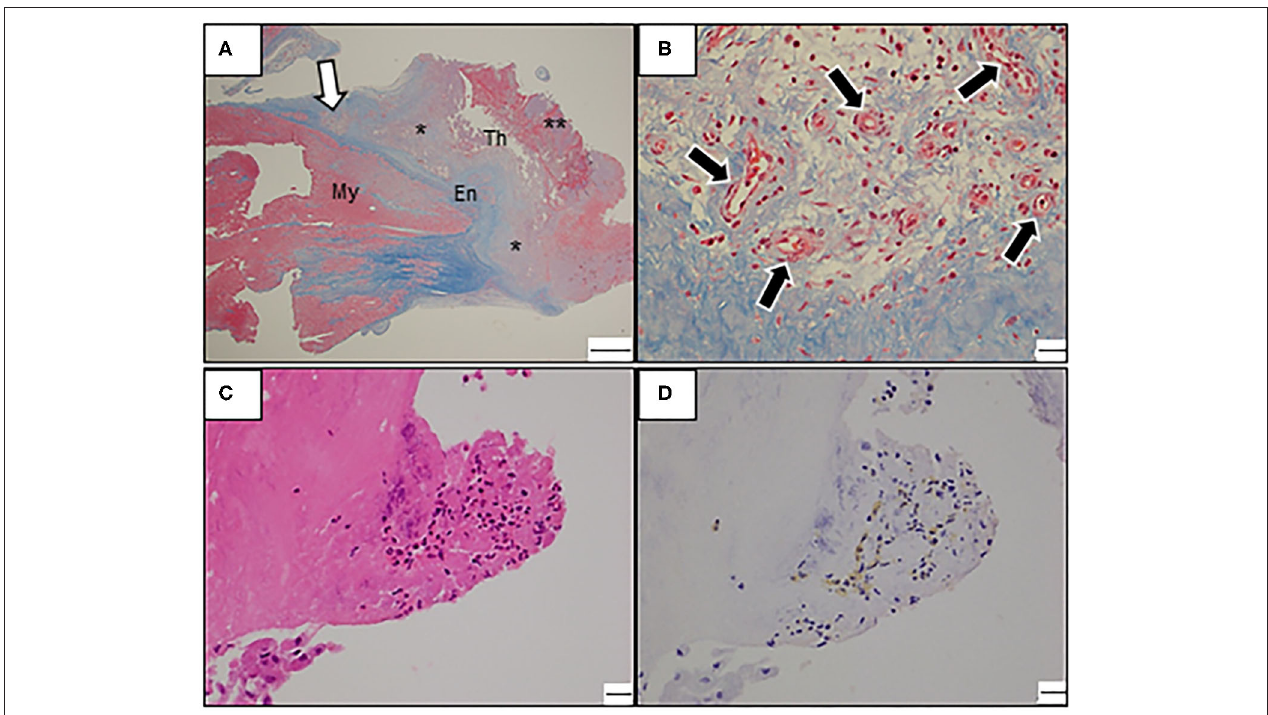
FIGURE 4 | (A–D) Photomicrograph of the resected mass. (A) Low-power view with Masson trichrome stain reveals endocardial fibrosis and intracardiac thrombosis at various stages. Note the mixed thrombus consisting of well-organized thrombus (asterisk) and fresh thrombus (double asterisk). En, Endocardium; My, Myocardium; Th, Thrombus; Bars: 1mm. (B) A high-power view reveals proliferating neovascularization (black arrows) with inflammatory infiltrates in the border zone of endocardial fibrosis and mural thrombus (magnified view around white arrow in A ). Bars: 20 µ m. (C) A high-power view with hematoxylin-eosin stain reveals focal eosinophilic infiltrate in the endocardium. Bars: 20 µ m. (D) Immunostaining with an antibody against the major basic protein. Bars: 20 µ m.